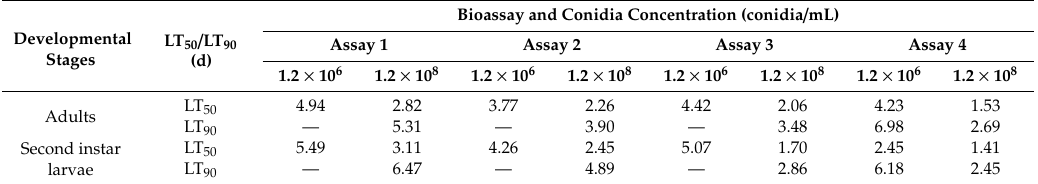
Table 4. Lethal time values (LT 50 and LT 90 ) for the adults and second instar larvae of WFT infected by M. flavoviride WSWL51721 in four di ff erent bioassays. Developmental